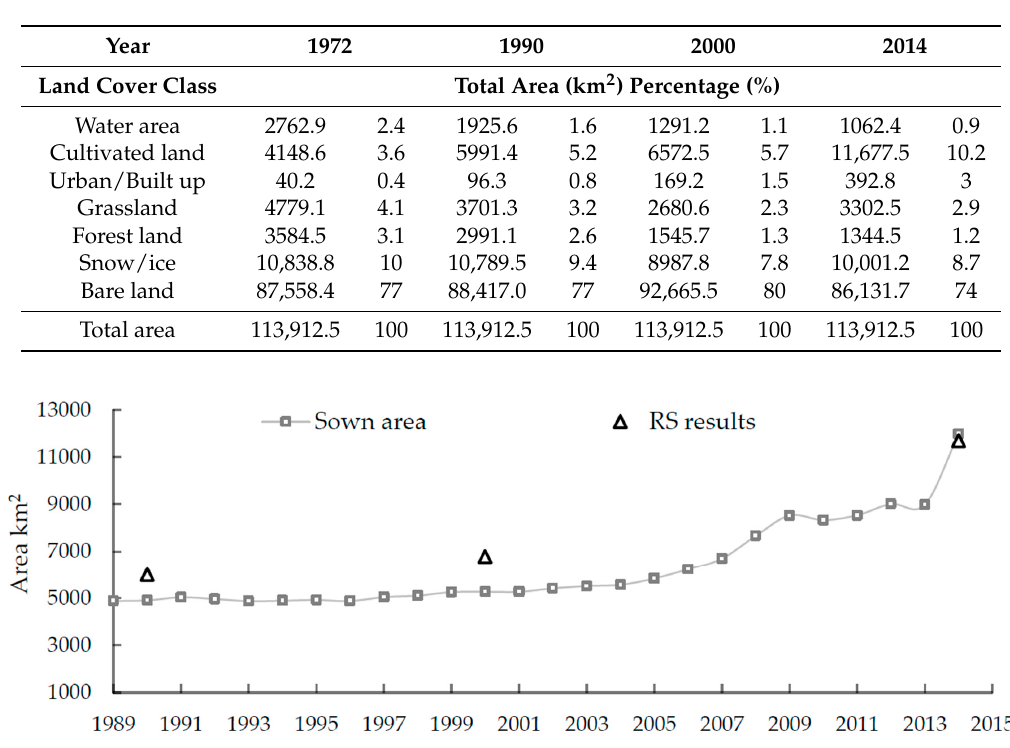
Figure 4. LC map of study area in 1972, 1990, 2000 and 2014. Table 4. Results of land use/cover change (LUCC) statistics for 1972, 1990, 2000, and 2014.